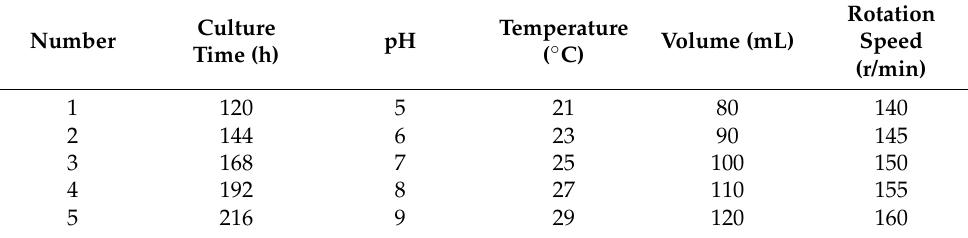
Table 3. The screening conditions on culture time, pH, temperature, volume, and rotation